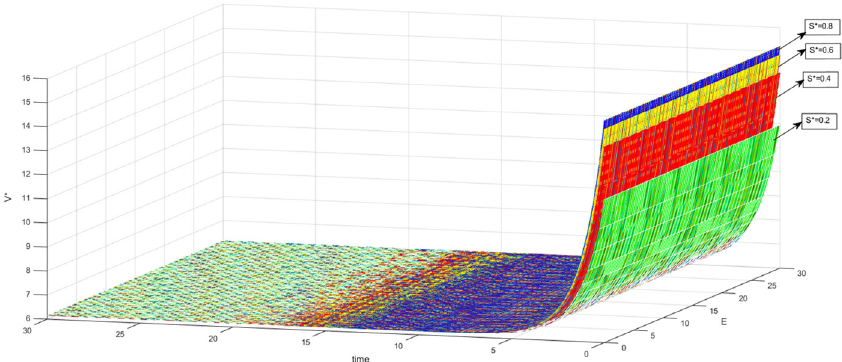
Figure 4: The change of government ’ s optimal bene fi t under di ff erent optimal subsidy ratios.